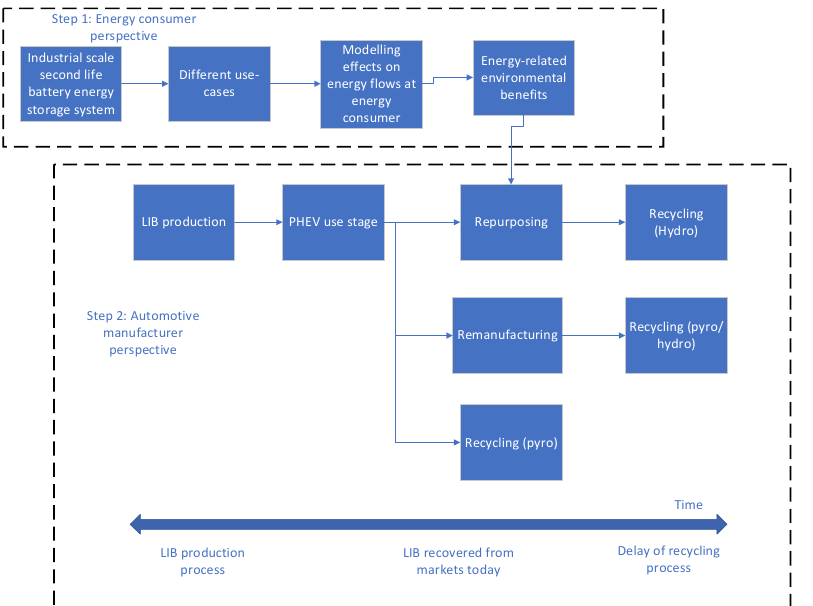
Figure 12. Two-step process of battery second-life application for energy storage system and associated business models [44].